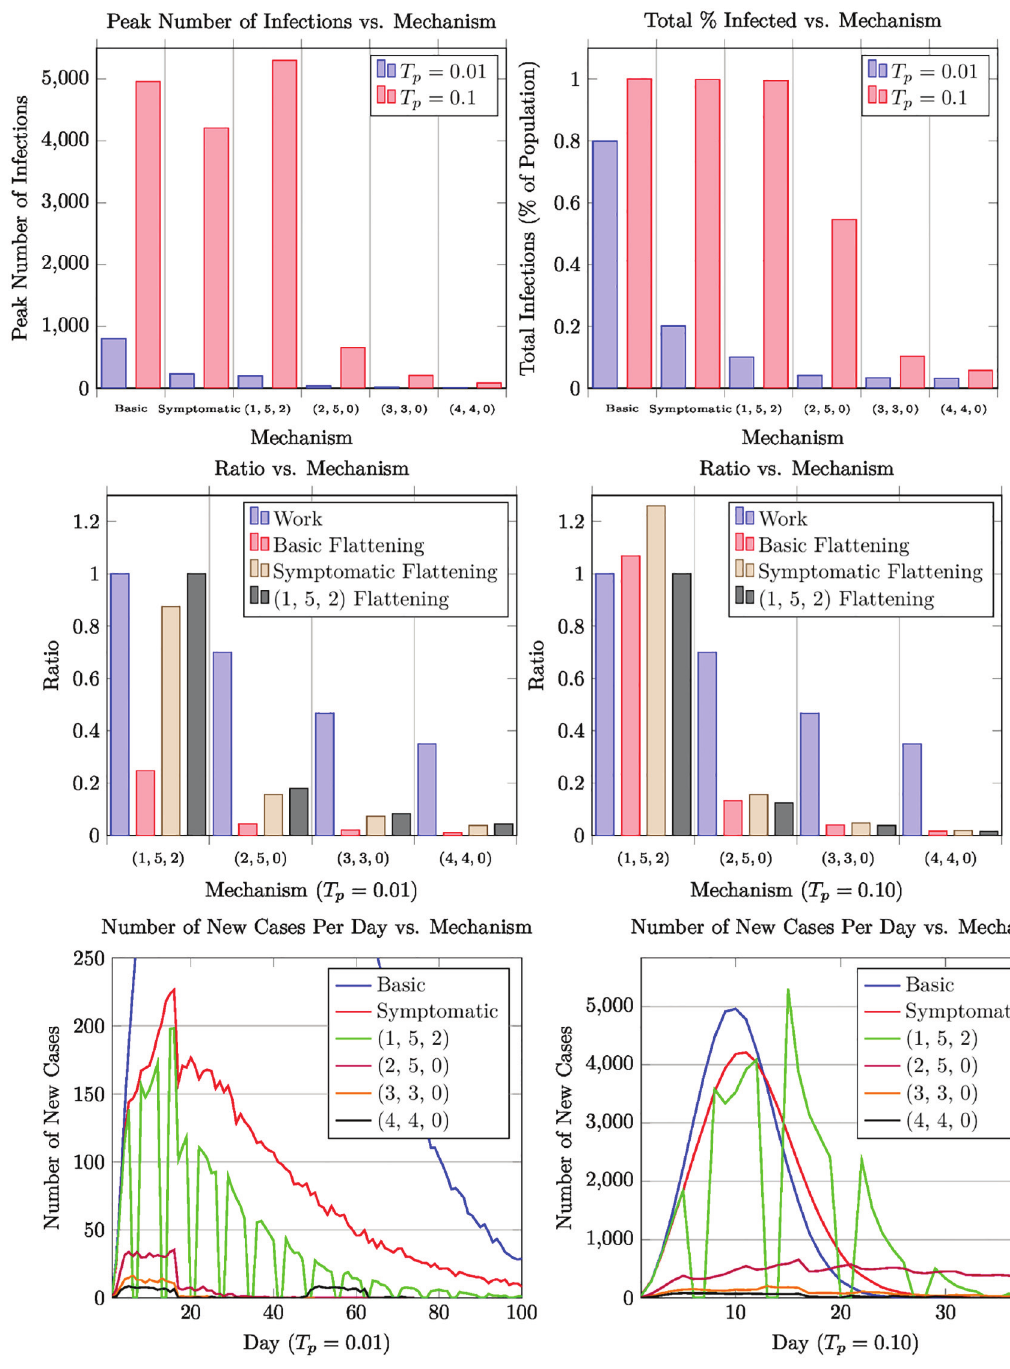
Fig 2. Plots displaying the performance of different mechanisms for Contact Graph Model.